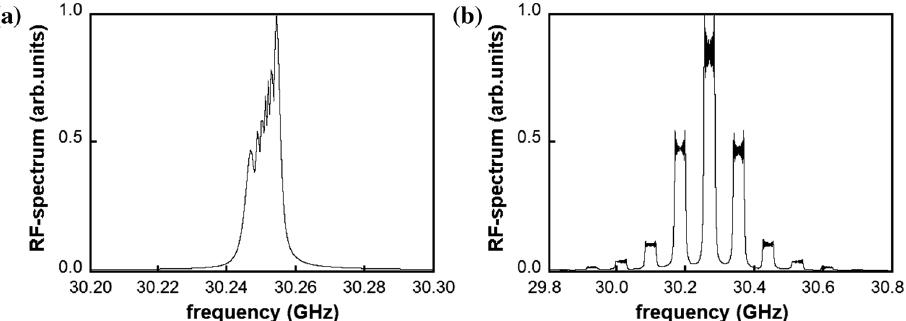
FIG. 7. The results of simulation of the radiation spectrum in the stationary oscillation regime for the coaxial BWO having a small drift of the electron energy on time: ( а ) with and (b) without a 2D Bragg